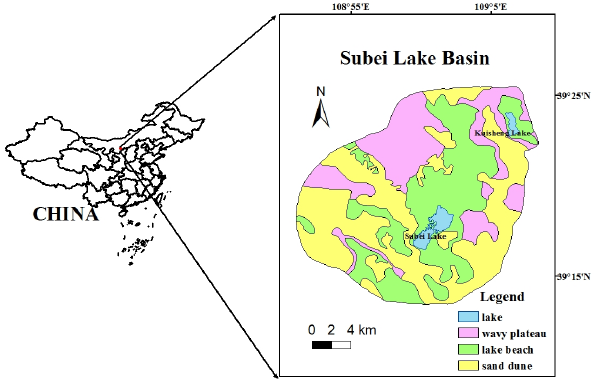
Figure 1. Location of the study area and geomorphic map.